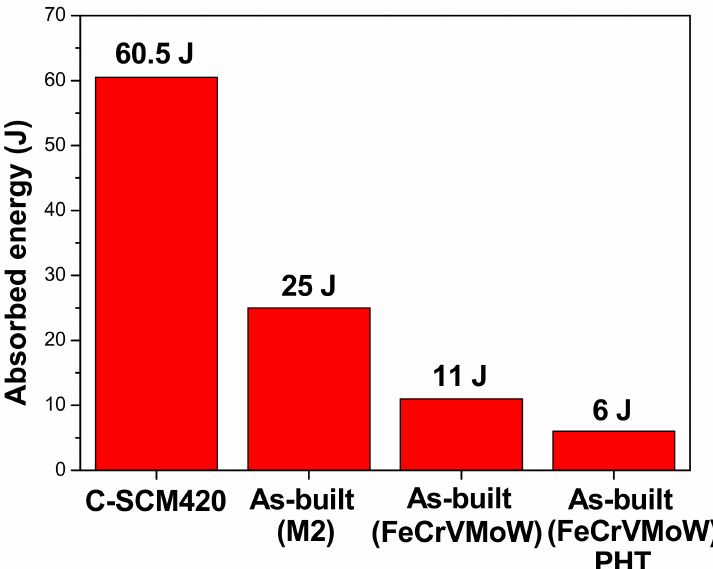
(Figure 14f), a transgranular fracture and a local area with concentrated microdimples, were observed. The deposited regions of the as-built (FeCrVMoW) and the as-built (FeCrVMoW)- PHT, have similar fracture surfaces, regardless of heat treatment. Overall, intergranular fractures and transgranular fractures were both observed, with intergranular fractures occurring more frequently. In addition, the deposited region of the as-built (FeCrVMoW)- PHT (Figure 14g), exhibited a greater complexity in the fractures. Brittle fractures and dimples agglomerated in a small area were also observed in the substrate.